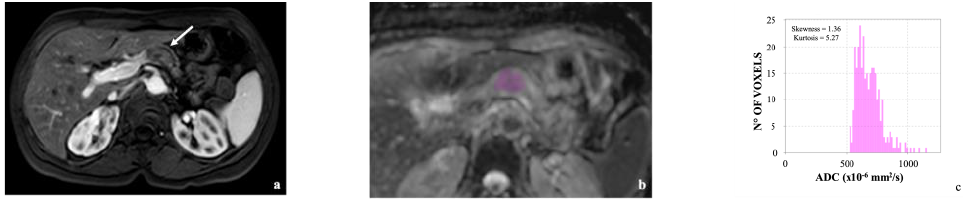
Figure 2. 57-year-old man with pancreatic body carcinoma (arrow in a , purple ROI in b ); ( c ) histo- gram analysis resulted in a skewness of 1.36 and a kurtosis of 5.27. Hepatic metastases developed 12 months after distal pancreatectomy.